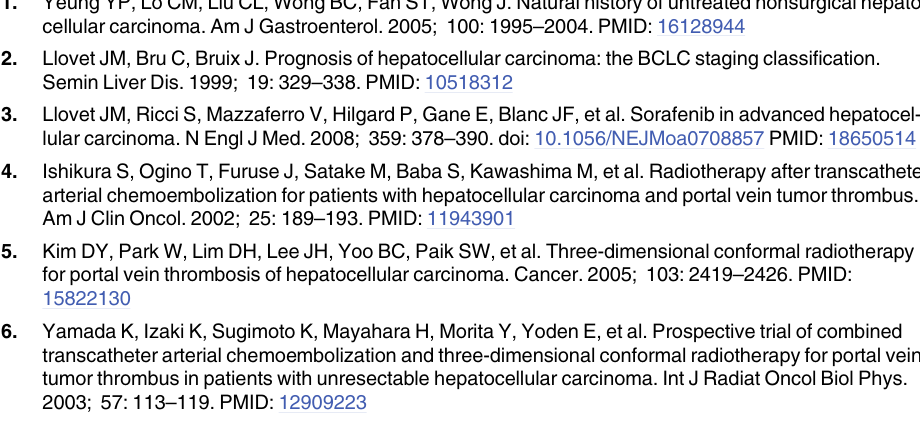
S1 Table. Raw data excel file for Tables 1 and 2, Figs 1A, 1B, 2A and 3A. This raw data excel file shows patients characteristics (age, gender, Child-Pugh class, ECOG performance status, initial AFP level, viral etiology, tumor size, site of PVTT, and modified UICC stage), treatment outcomes (AFP response and best radiologic response), and oncologic outcomes (PFS and OS) for entire patients (n = 154). S2 Table. Raw data excel file for Tables 1, 2, 3 and 4, Figs 2B and 3B. This raw data excel file shows patients characteristics (age, gender, Child-Pugh class, ECOG performance status, initial AFP level, viral etiology, tumor size, site of PVTT, and modified UICC stage), treatment out- comes (AFP response and best radiologic response), and oncologic outcomes (PFS and OS) for propensity score matched patients (92